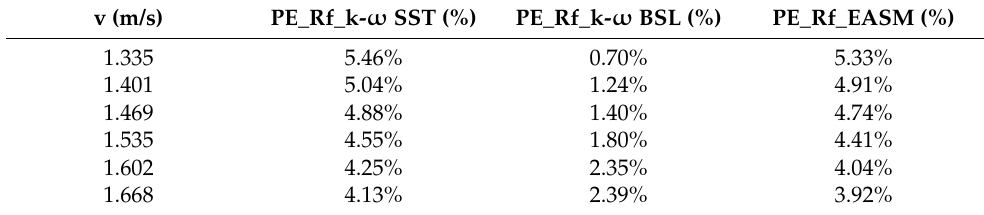
Figure 12. Comparison between model test and CFD simulation with SHIPFLOW: ( a ) frictional resistance; ( b ) frictional resistance coefficient; ( c ) total resistance coefficient. Table 3. Percentage error between experimental test and CFD simulation with SHIPFLOW for the Frictional Resistance (Rf). v (m/s)